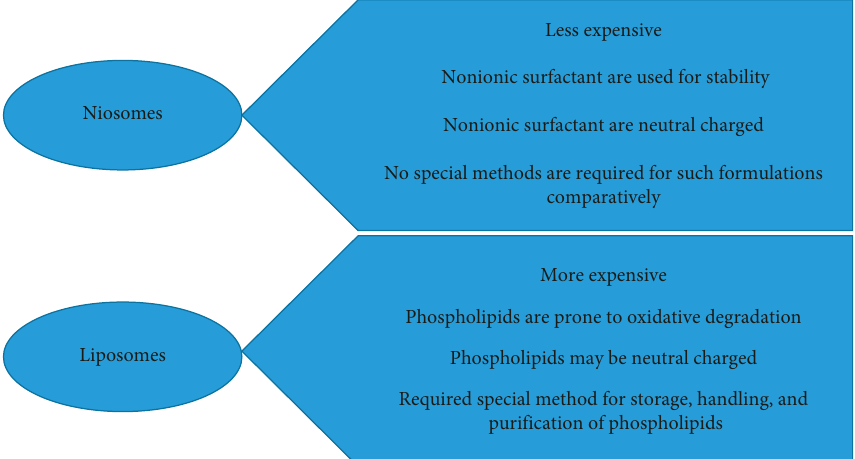
Figure 5: Major differences in characteristics between liposomes and niosomes.